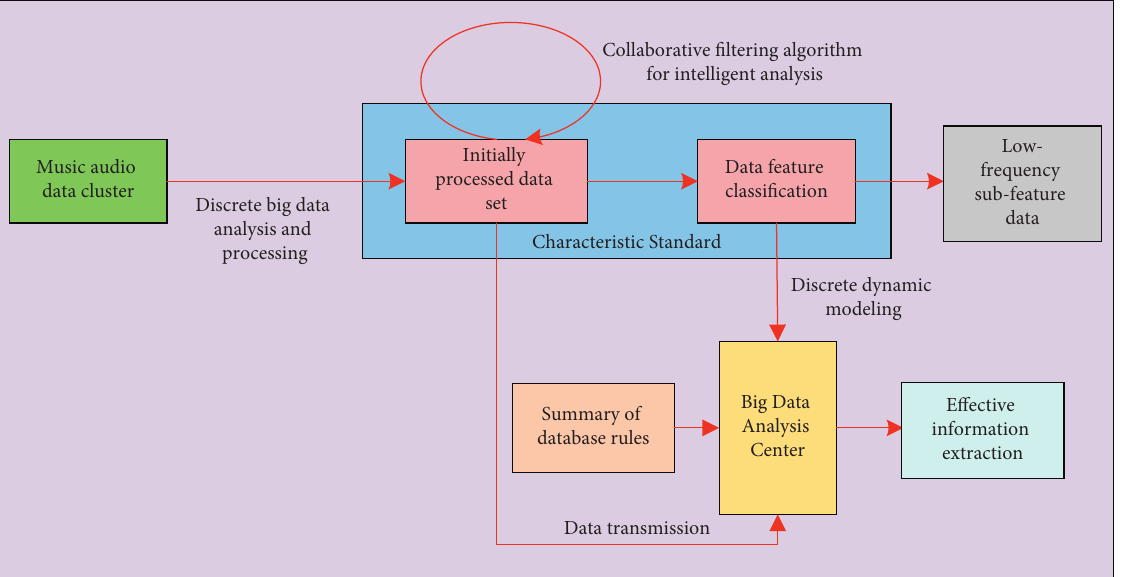
Figure 5: Data operation and information extraction process of the music sound database based on collaborative filtering algorithm.